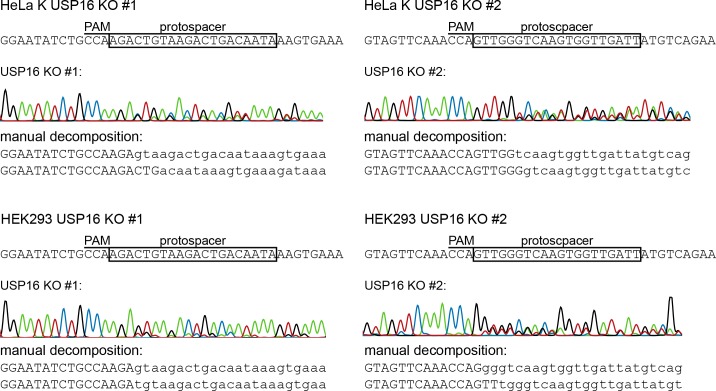
Validation of USP16 knockout cell lines generated by CRISPR/Cas9.Genomic sequences of the USP16-/- isogenic HeLa and HEK293 KO clones generated in this study using two different guide RNAs targeting different exons (exon three for KO #1 and exon five for KO #2). Sanger sequencing chromatograms show indel mutations in the USP16 gene targeted by CRISPR. The top sequence indicates the WT sequence of the target region and the location of the protospacer and the protospacer adjacent motif (PAM). The overlapping peaks in the chromatogram of the sequenced clone indicate the presence of two different indel mutations in the two copies of the USP16 gene. Manual decomposition of the chromatogram shows the two resulting sequences in the target region and confirms frame-shift indels in both alleles.